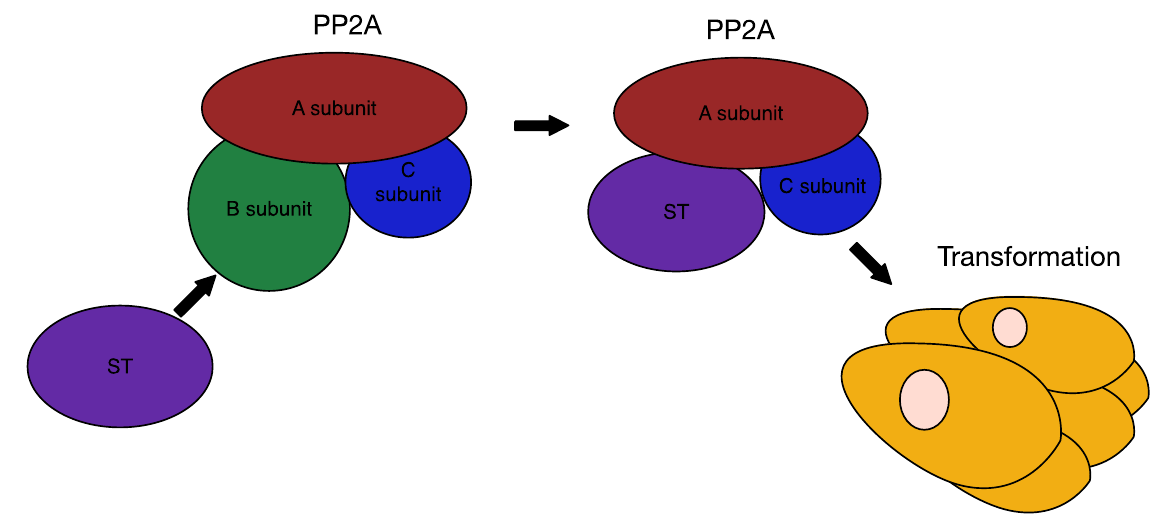
Figure 9. Interaction of ST with PP2A. Polyomavirus ST competes with the B subunit of PP2A for binding to the structural A subunit and the catalytic C subunit. In SV40, this interaction between ST and PP2A Aα leads to cell transformation. Although the interaction of MCPyV ST with PP2A Aα may not be necessary for transformation, interaction with PP2A Aβ or the related PP4C may play a